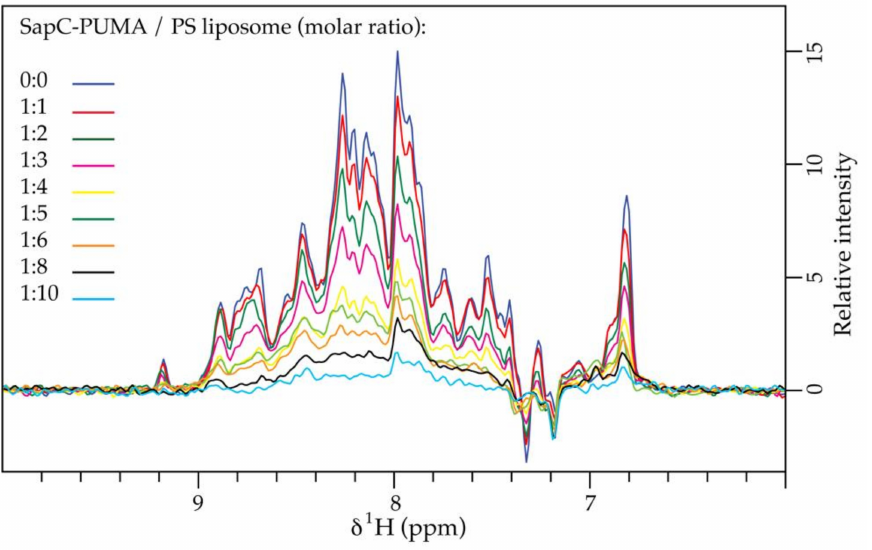
Figure 6. SapC-PUMA binds to liposomes at pH 6: 1D projections of [ 1 H- 15 N]-sofast-HMQC experiments on chimera-liposome mixtures at increasing lipid concentration, showing the decrease in NMR signal intensity due to protein-liposome binding. 3.3. Binding of SapC-PUMA to Liposomes Can Be Tuned by Modifying the Electrostatic Surface of